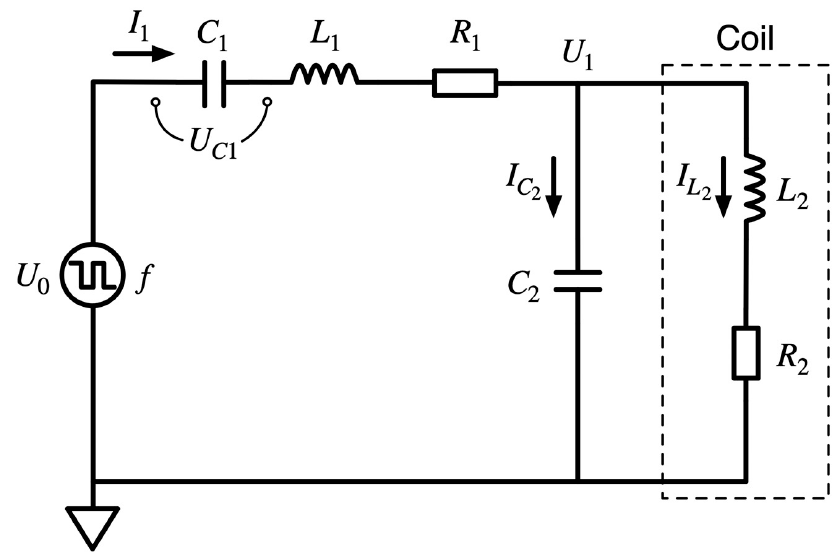
Figure 6. Mathematical calculation of the equivalent excitation circuit structure.